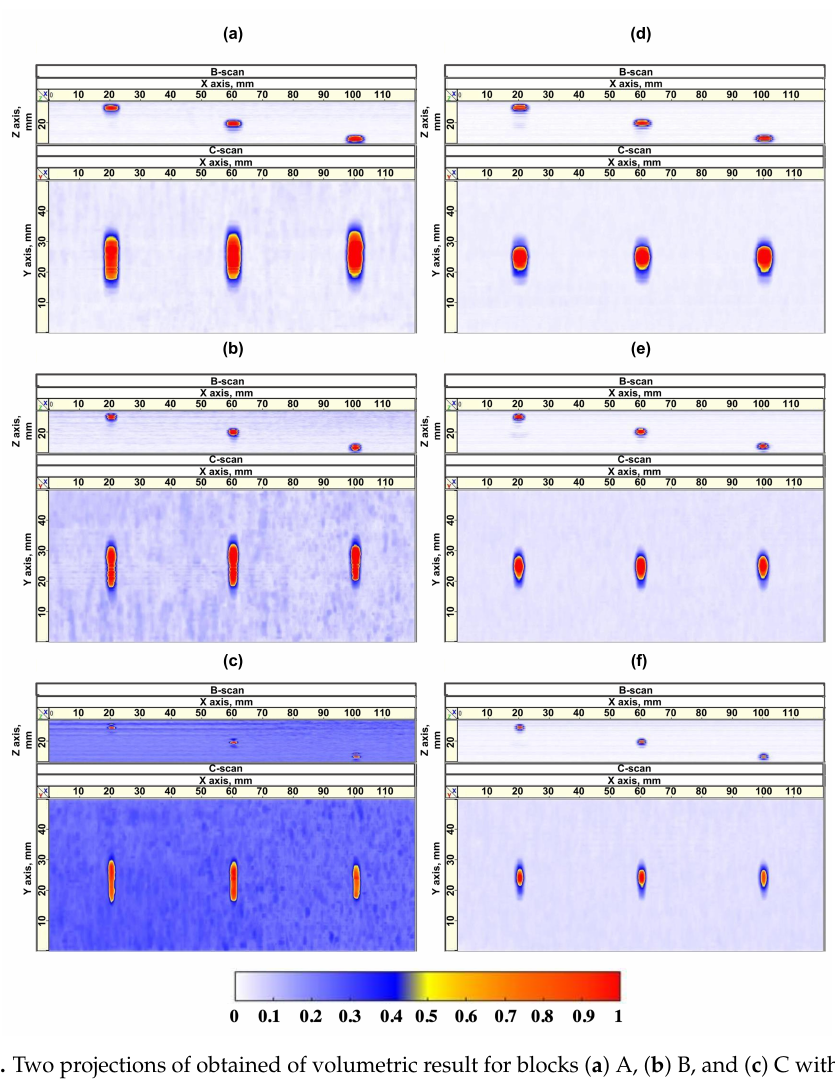
Figure 9. Two projections of obtained of volumetric result for blocks ( a ) A, ( b ) B, and ( c ) C without lens and blocks ( d ) A, ( e ) B, and ( f ) C using PR-FZP.